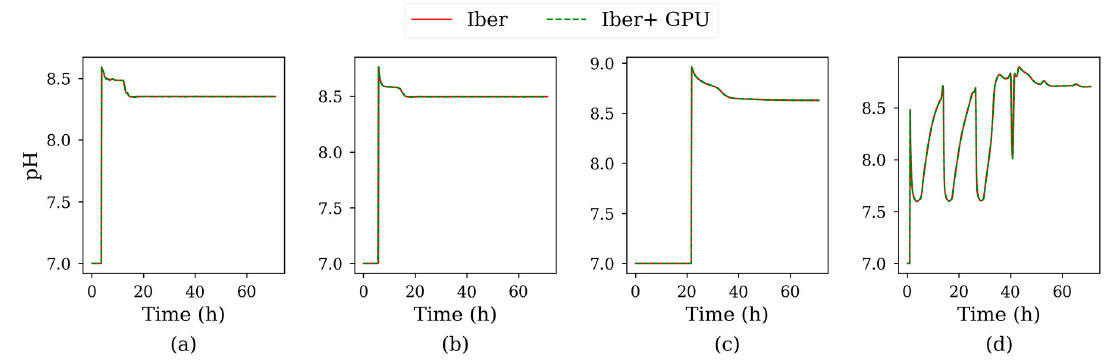
Figure A6. Time series of pH for Test 4, sampled at control points P1 ( a ), P2 ( b ), P3 ( c ) and P4 ( d ).